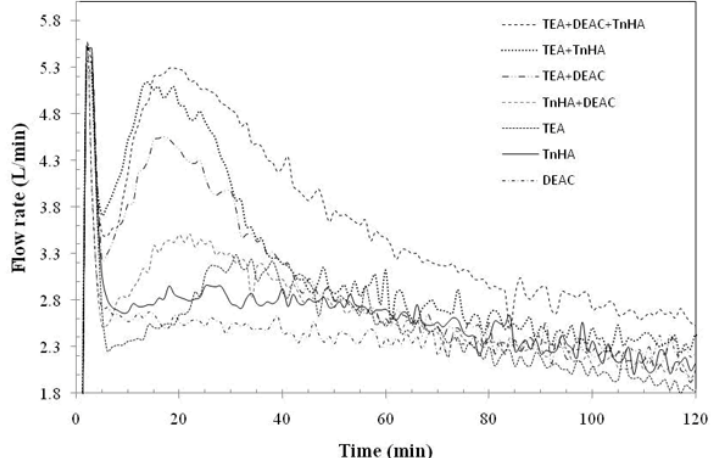
Figure 4. Kinetic profile based on ethylene consumption with various activators for ethylene/1-hexene